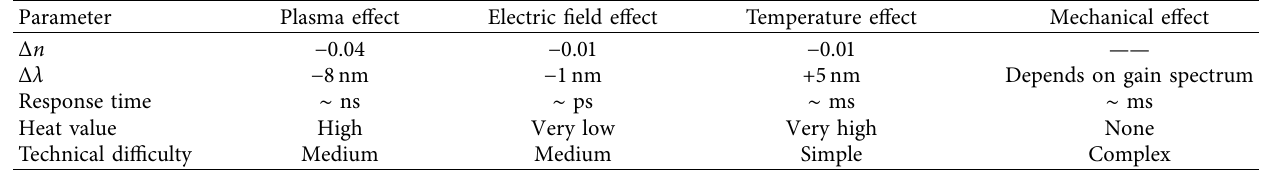
Table 1: Comparison of characteristics among four wavelength modulation